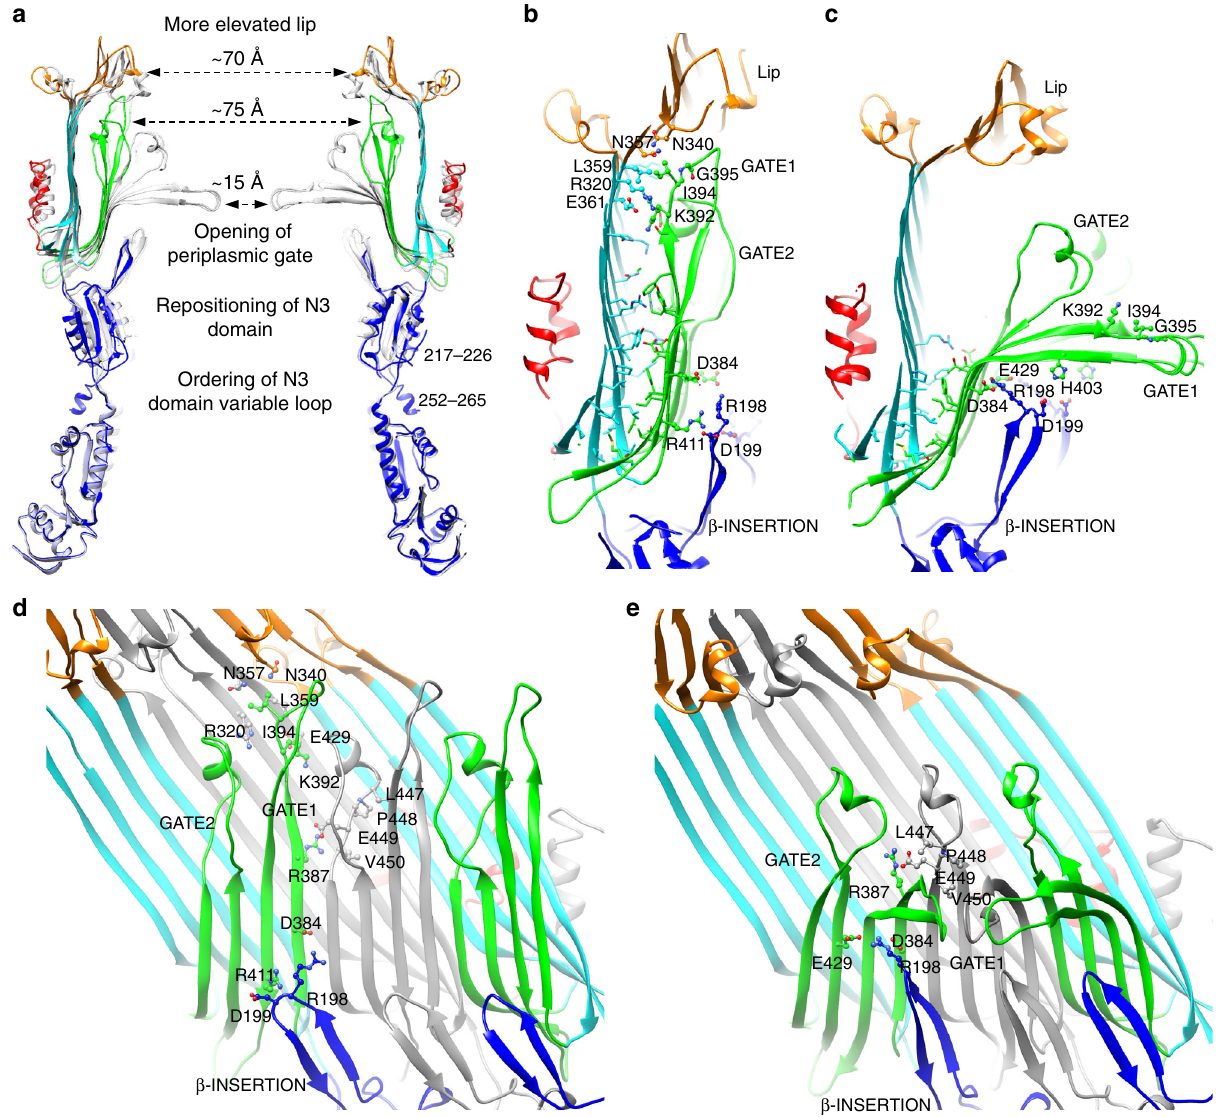
Fig. 5 Structural changes involved in InvG gate opening. a Comparison of the InvG secretin gate open state (colored as per Fig. 1) and the closed state (gray transparent). The major structural changes are the ordering of the N3 domain variable loop (residues 217 – 226 and 252 – 265, disordered in other secretin structures) and accompanying change in N3 domain position, the opening of the periplasmic gate involving the repositioning of GATE1 and GATE2, and the more elevated lip region caused by interactions with GATE1 and the insertion of the assembled needle fi lament. b and c – side view – and d and e inside view – compare the interface between outer and inner β -barrels in the open and closed states, respectively with accompanying interface areas of 2111 Å 2 and 1153 Å 2 , residues forming the open and closed interfaces shown as sticks in b and c . The core interface at the base of the β -sandwich formed by the outer and inner β -barrels is predominantly hydrophobic while the region formed by the extension of the GATE1 and GATE2 hairpins is mostly polar in nature. Key interactions de fi ning the open and closed conformations between the N3 domain β -INSERTION, the inner β -barrel GATE1 and GATE2 motifs, and the upper outer β -barrel and lip are labeled and shown as ball and stick. The middle subunit is colored gray in d and e to de fi ne the outer and inner β - barrels. The closed gate conformation is supported by interactions of the N3 β -INSERTION, speci fi cally Arg 198 , with the kinked regions of the GATE1 (Asp 384 ) and GATE2 (Glu 429 ) hairpins and further supported by the surrounding network of interactions. In the open gate conformation, the N3 β - INSERTION interface is disrupted and the gate forming GATE1 hairpin is now extended toward the lip and packed against the outer β -barrel with Ile 394 at the tip packing in a hydrophobic notch formed by the side chains of Arg 320 , Asn 340 , Asn 357 , and Leu 359 . The GATE2 hairpin undergoes a signi fi cant rotation with residues stabilizing the closed gate — Leu 447 , Pro 448 , Glu 449 , and Val 450 — packing against the outer β -barrel wall. A salt bridge between GATE2 Glu 449 and GATE1 Arg 387 is maintained between closed and open